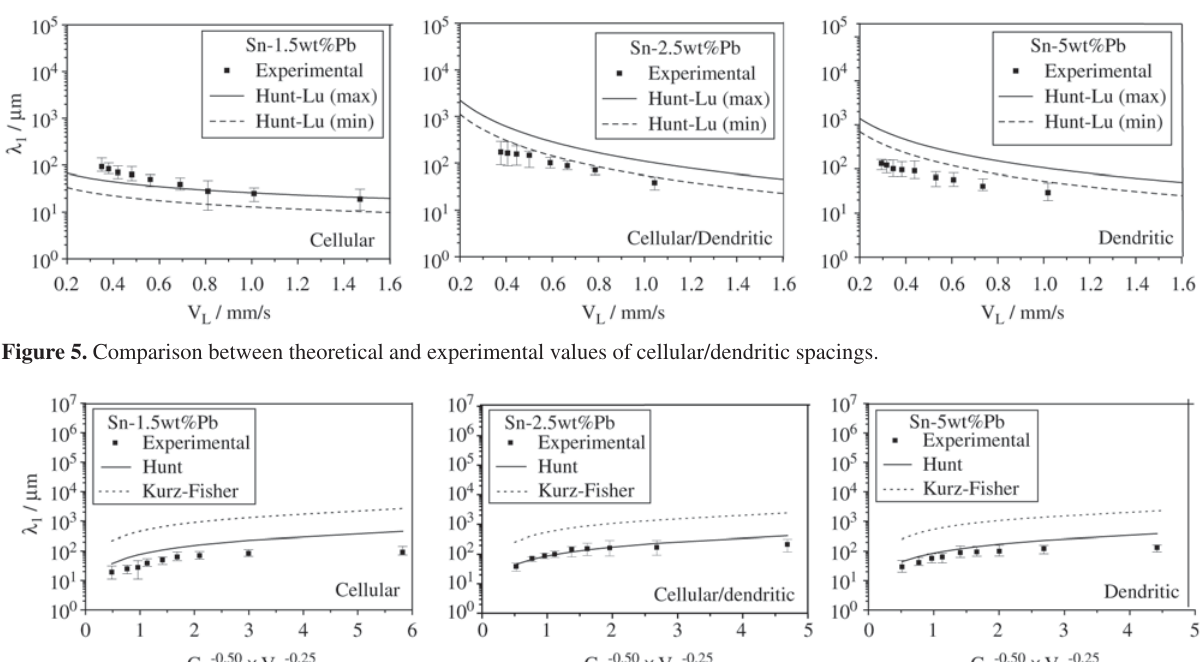
=163 mm, V = 0.4 mm/s, • T = 0.28 1 L